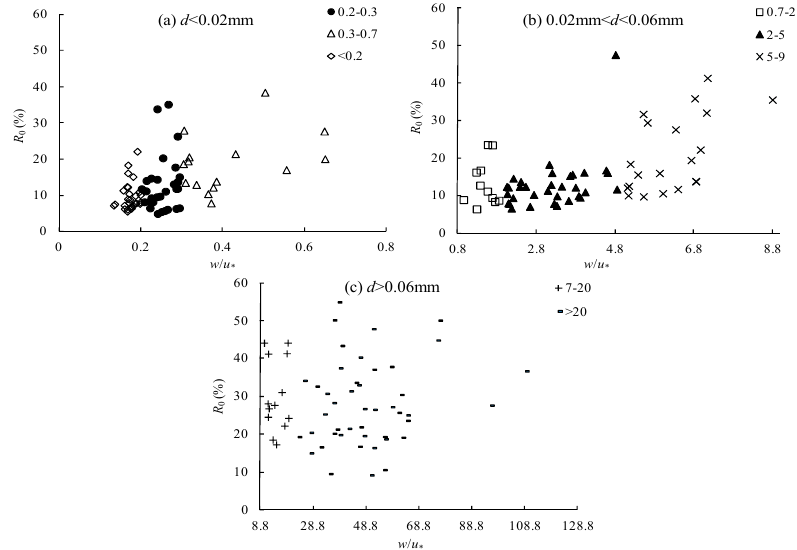
Figure 8. Relationship between R 0 , ω / u * and particle diameters, ( a ) d < 0.02 mm, ( b ) 0.02 mm < d < 0.06 mm, and ( c ) d > 0.06 mm. The legends are the values of ω / u * . R 0 = contribution ratio of the two near-bed points, ω = settling velocity, and u * = shear velocity.